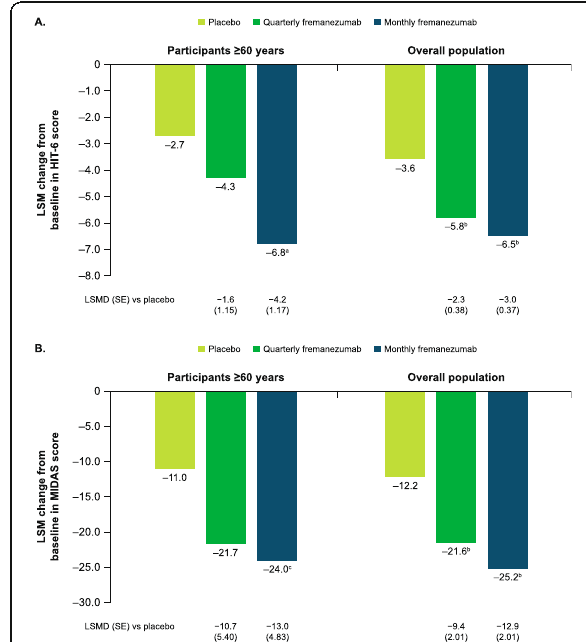
Fig. 6 Change in A ) HIT-6 and B ) MIDAS scores in participants aged ≥ 60 years and overall population. HIT-6, 6-item Headache Impact Test; MIDAS, Migraine Disability Assessment; LSM, least-squares mean; LSMD, least-squares mean difference; SE, standard error. Data shown are the LSM changes from baseline in HIT-6 and MIDAS scores during 12 weeks of double-blind treatment. a P = 0.0005 vs placebo. b P < 0.0001 vs placebo. c P < 0.01 vs